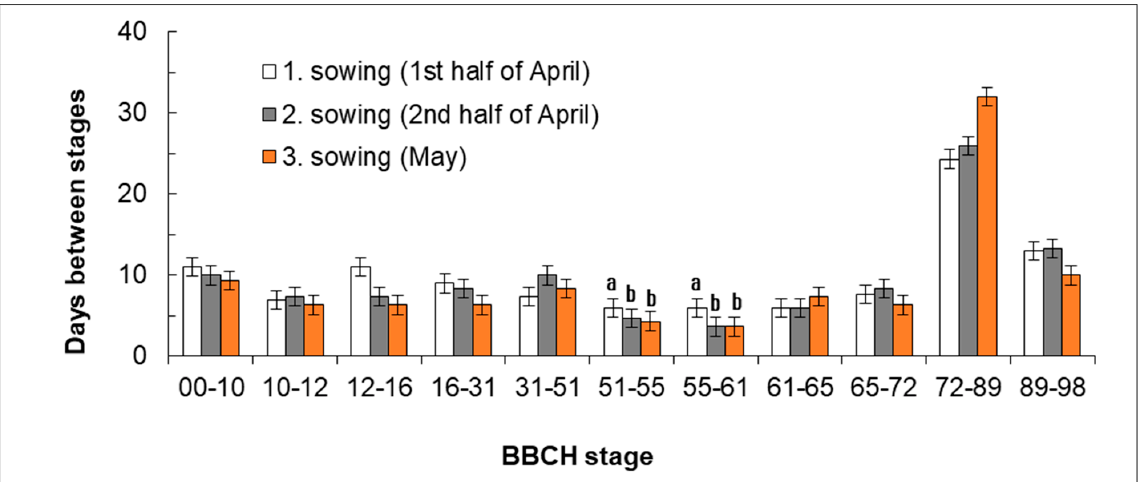
Figure 3. Effect of sowing date on the number of days for reaching the range of developmental stages. Mean values ( n = 9) of individual variants are shown for the specific range of developmental stages (BBCH) in three years of study ± SD. Different letter indices are present only in variants in which significant differences were found ( p < 0.05). If no letter indices are included, no significant difference was found between the respective variants.